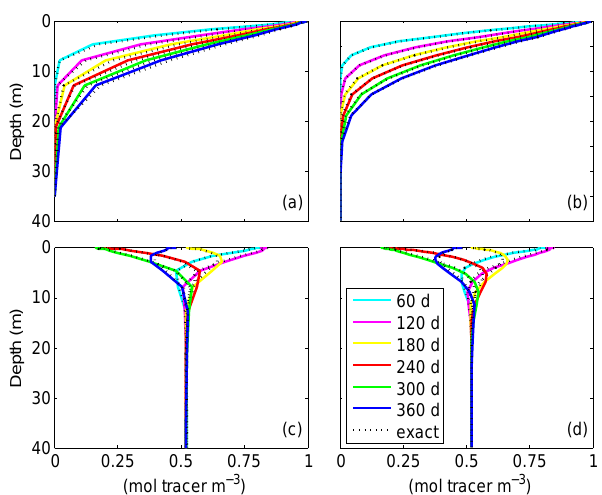
Fig. 4. Comparison between analytical (denoted as exact in the fig- ure) and numerical solutions: (a) and (b) are for the pulse type solu- tion described in Eq. (23); (c) and (d) are for the wave type solution described in Eq. (24). The left panels used the standard transformed exponential discretization for a soil column in CLM4 (see Eq. 6.5 in Oleson et al., 2010). The right panels used a refined discretization by doubling the number of nodes in the transformed exponential grid. See text for details of the